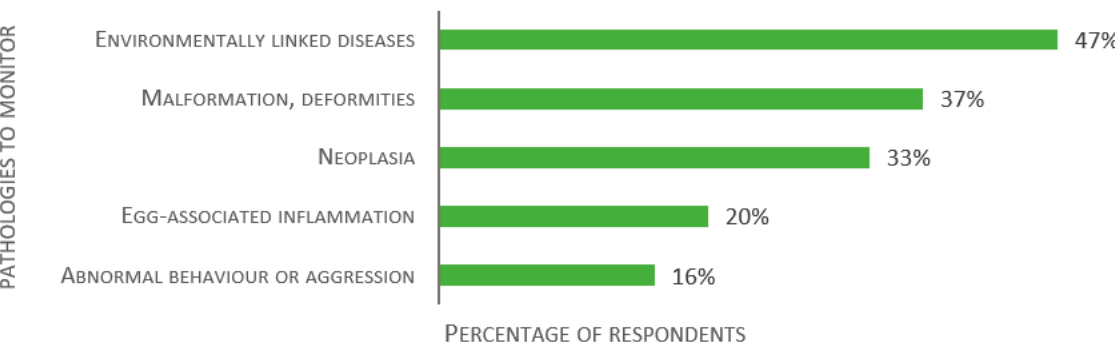
Figure 7. Replies to the open-ended question: “Please list what you consider the main pathogens to monitor in the fish (other than zebrafish) laboratory”, presented as percentage of respondents ( n = 43).